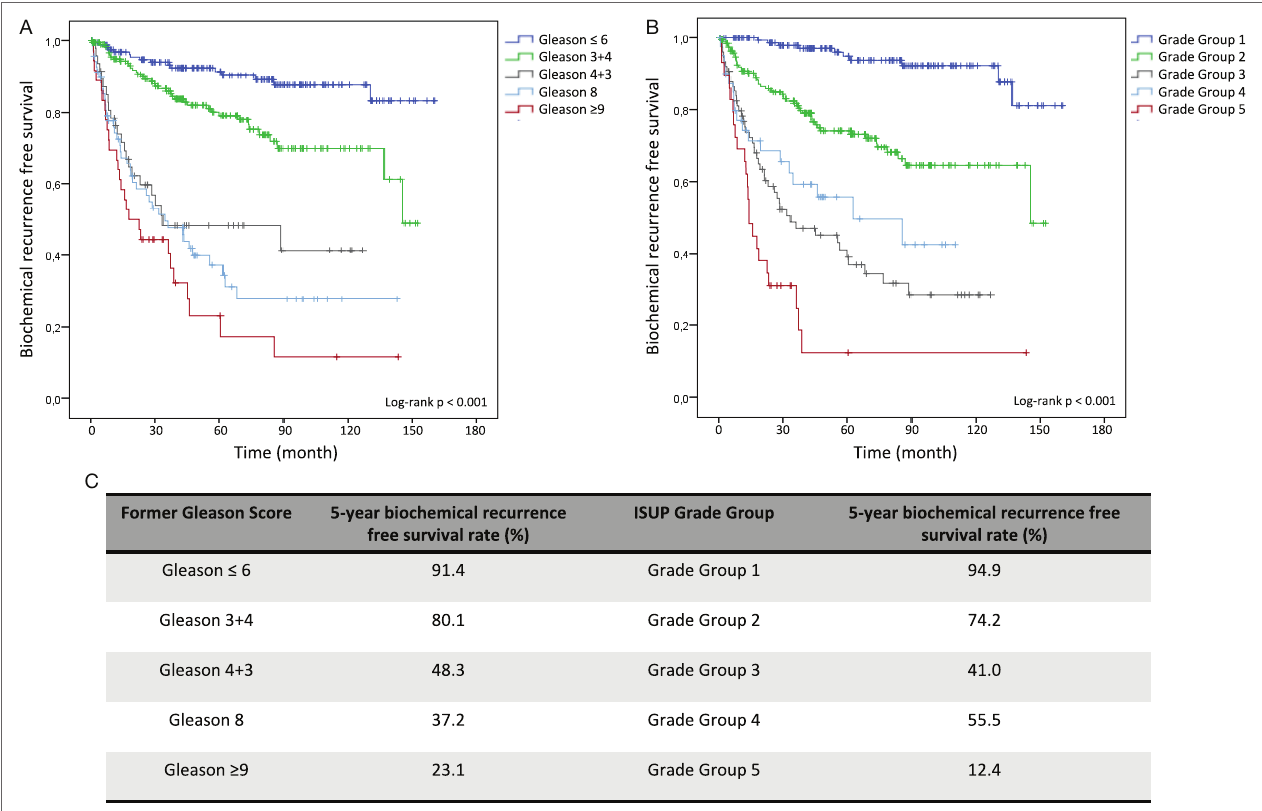
FigUre 1 | Kaplan–Meier analysis for biochemical recurrence free survival (BFS) according to the former Gleason Grading and International Society of Urological Pathology (ISUP) Grade Groups on RP specimens. (a) Biochemical recurrence-free survival (BFS) stratified by Gleason ≤ 6, Gleason 3 + 4, Gleason 4 + 3, Gleason 8 and Gleason ≥ 9. (b) BFS stratified by Grade Group 1, Grade Group 2, Grade Group 3, Grade Group 4, and Grade Group 5. (c) 5-year BFS rate in % for grading according to former Gleason Grading or ISUP Grade